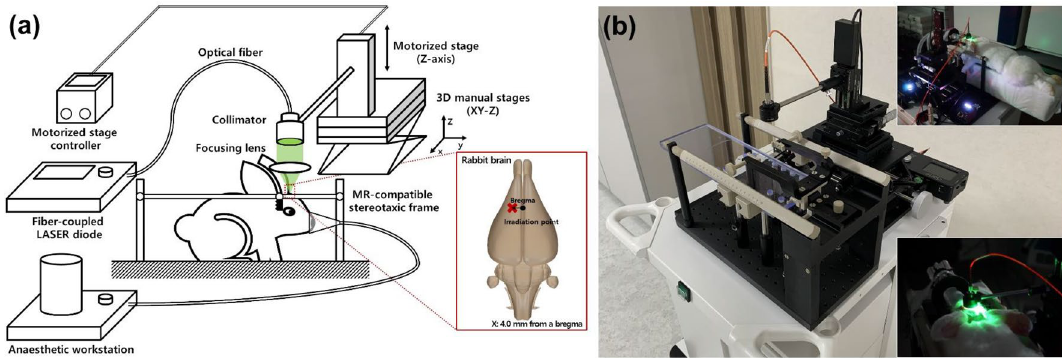
Figure 1. ( a ) Schematic of a photochemical thrombosis investigation system to establish the ischemic stroke middle animal (rabbit) model. The system consists of a stereotaxic frame for positioning an animal, a light irradiation part for inducing photochemical thrombosis in a specific area, and an irradiation probe-positioning part consisting of a three-dimensional manual stage and a motorized stage for controlling the lateral and axial positions accurately. Using the developed system, light for localized photochemical thrombosis was exposed at a distance of 4.0 mm in the X-axis from a bregma of a rabbit brain, which is an area corresponding to the motor cortex of the hind leg, as described in an inlet figure. ( b ) Image of an entire photochemical thrombosis investigation system built on a medical cart for mobility. The inlet figure indicates the system used in an experiment for establishing the photothrombotic rabbit stroke